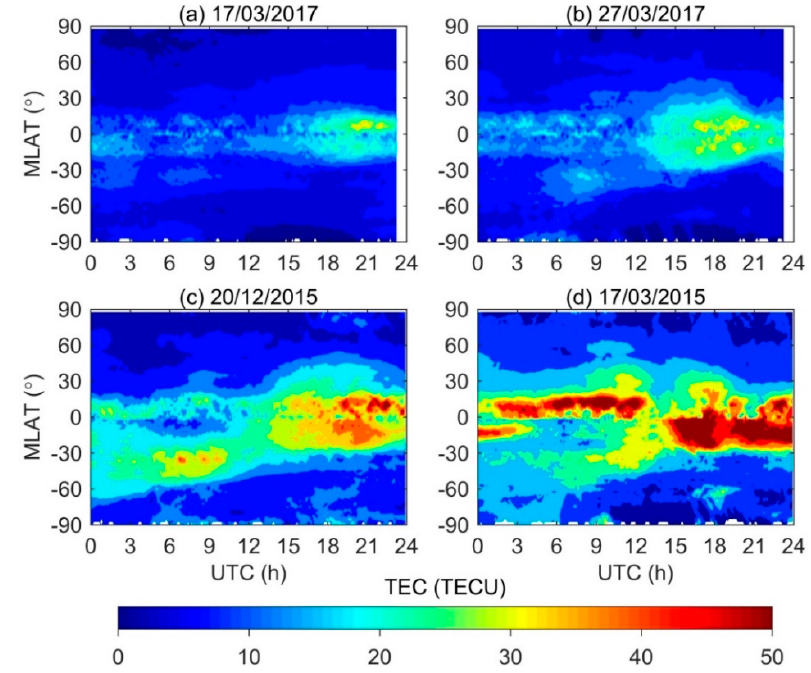
Figure 4. The temporal TEC variations from 90° S to 90° N MLAT on: ( a ) 17 March 2017 as the quiet day reference; ( b ) 27 March 2017 as the moderate storm; ( c ) 20 December 2015 as the intense storm; and ( d ) 17 March 2015 as the super storm, respectively.